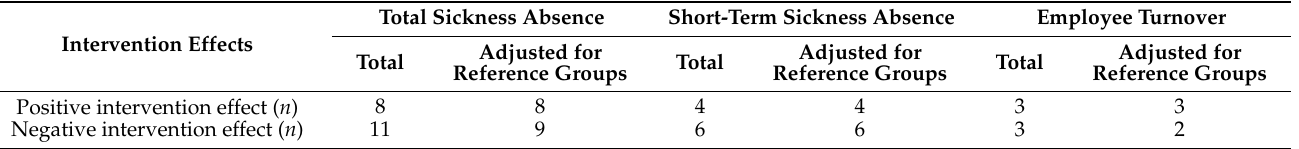
Figure 4. Distribution of estimated workplace-specific intervention effects on employee turnover and sickness absence among the 71 participating workplaces. Table 2. Workplace-specific intervention effects on sickness absence and employee turnover expressed as the number of the 71 intervention groups with a statistically significant ( p < 0.05) intervention effect. In total and after adjustment for the concurrent development within the reference groups (removing workplace-specific interventions effects that could be explained by the general development in the operational area or department instead of the